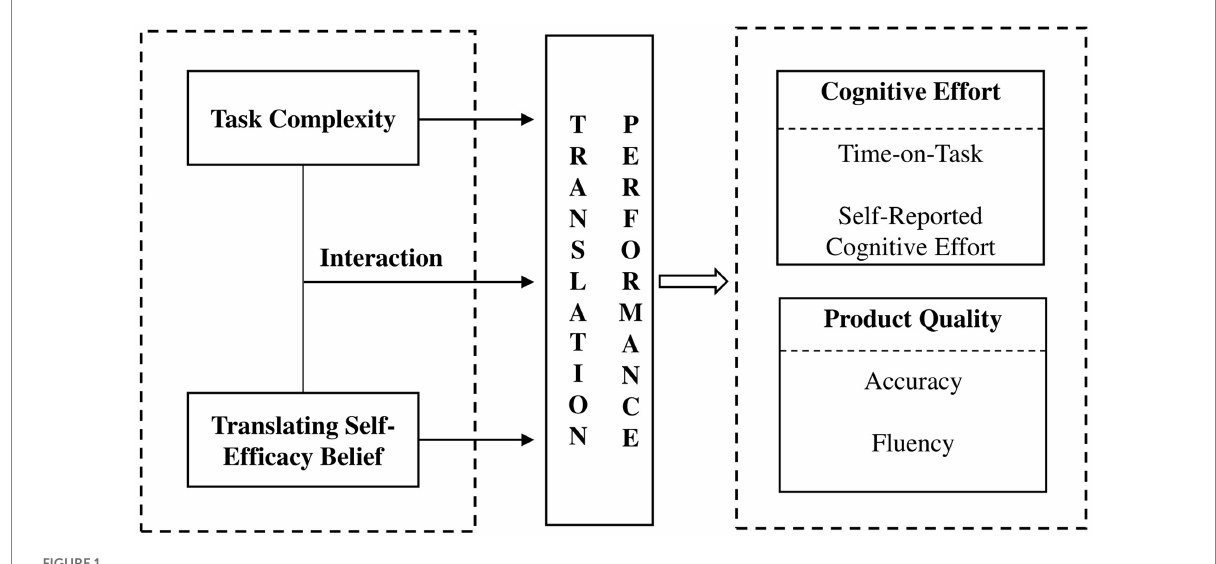
FIGURE 1 Proposed research framework of translation